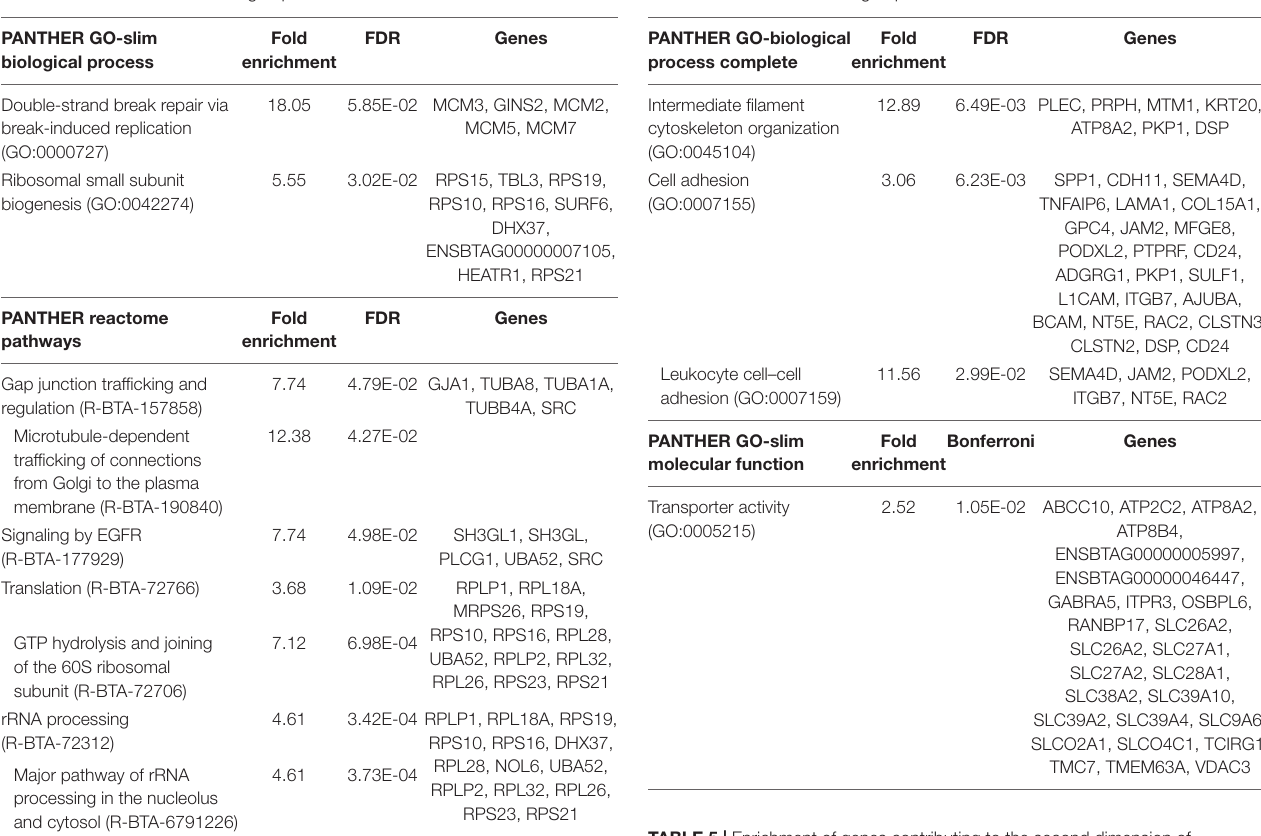
TABLE 5 | Enrichment of genes contributing to the second dimension of between-class PCA (positively correlated) and associated with ICM from the “SC” and “SF” IVP treatment groups.